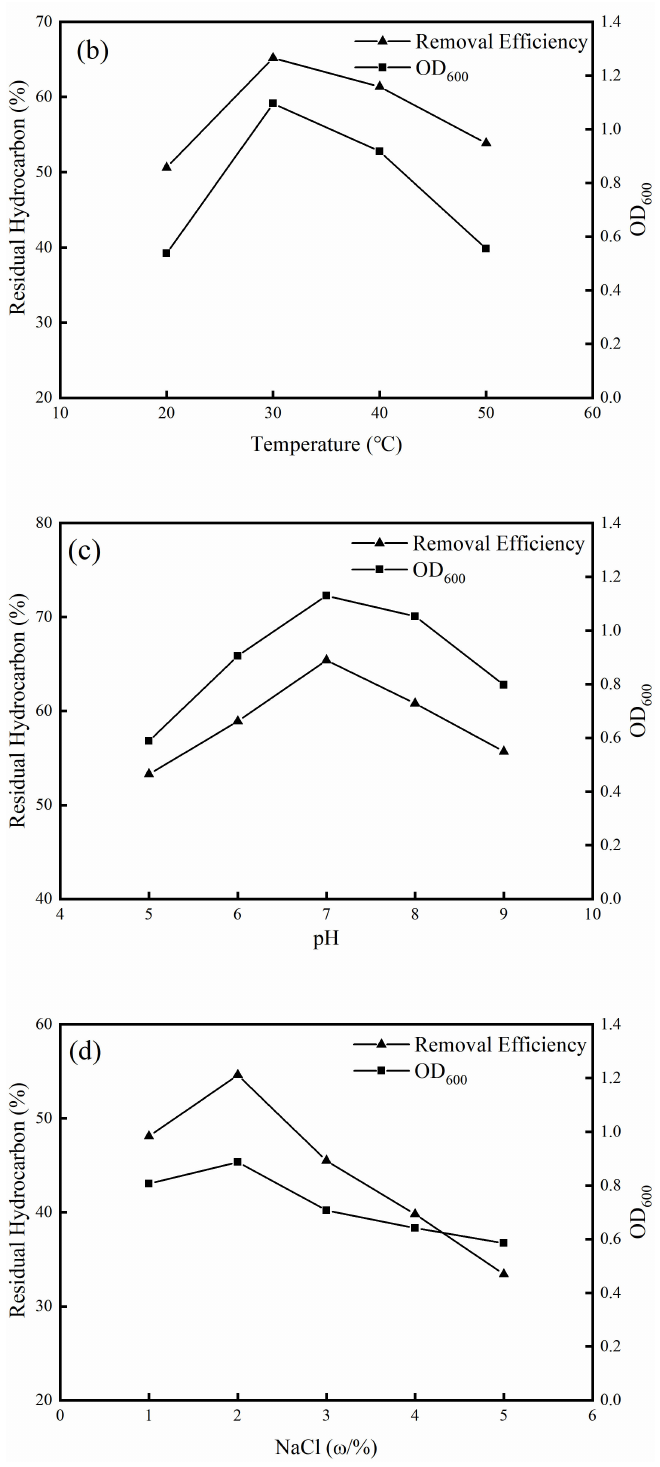
Figure 3. TPHs removal efficiency of the MX1 strain under different culture conditions. ( a ) Culture time; ( b ) temperature; ( c ) pH; ( d ) the concentration of